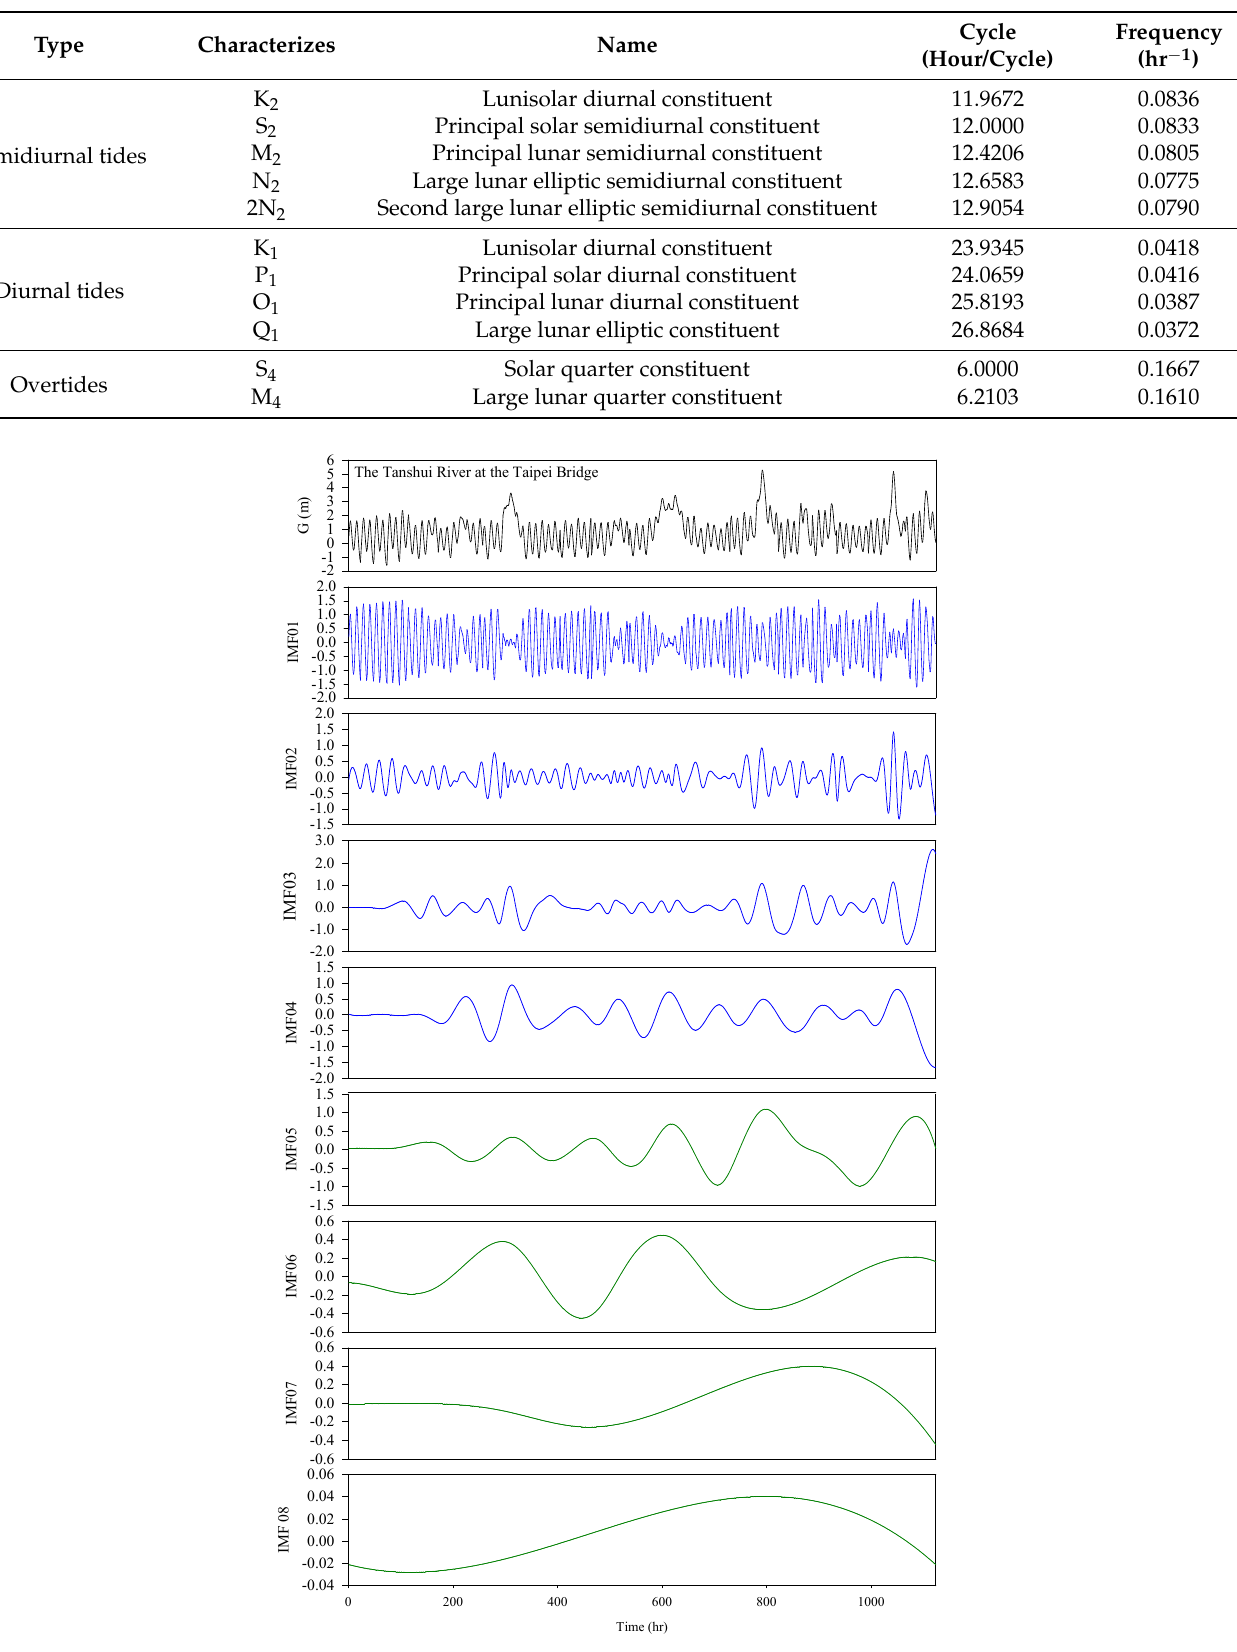
Figure 5. Water level hydrograph and IMFs of data from the Tanshui River at the Taipei Bridge.